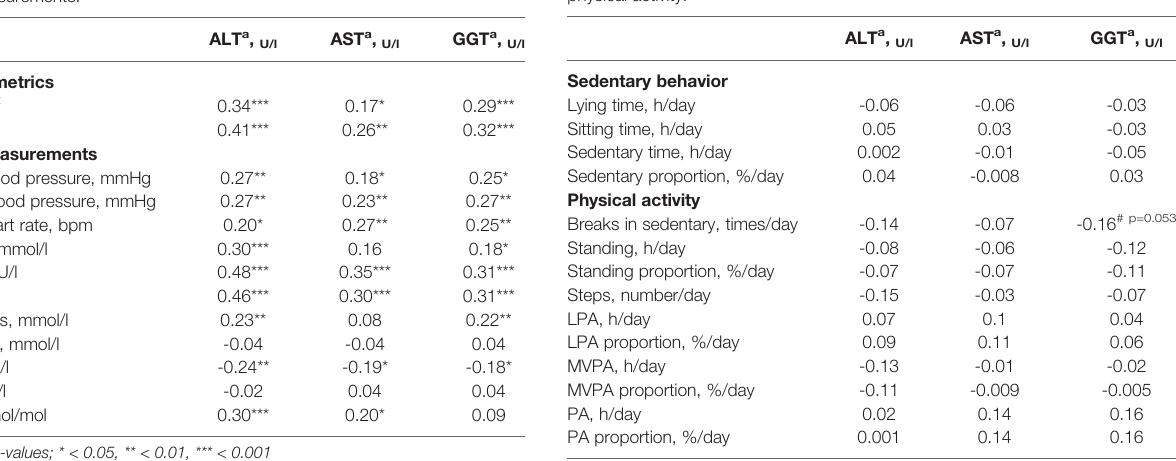
TABLE 3 | Age and sex-adjusted Pearson partial correlation coef fi cients between circulating liver enzymes (ALT, AST, GGT), sedentary behavior and physical